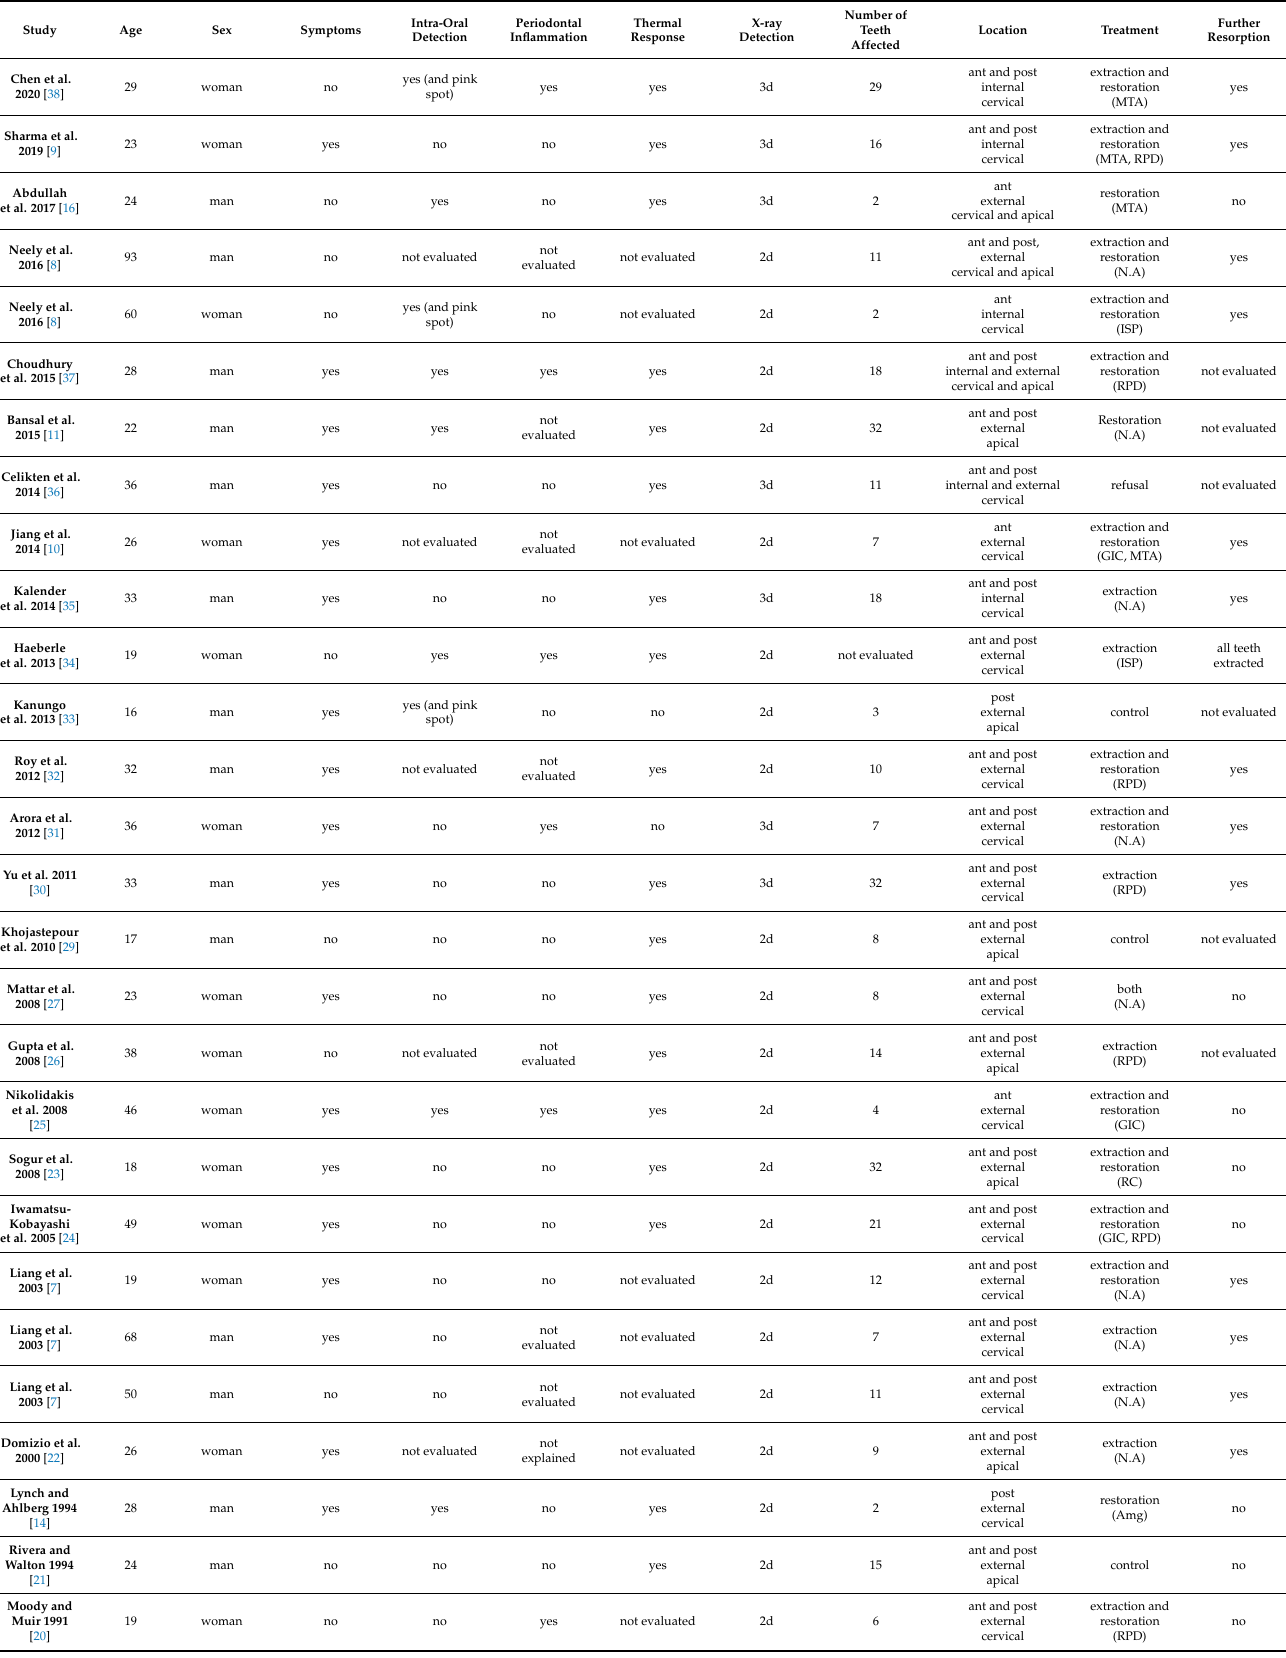
Table 2. Main characteristics and parameters of the included